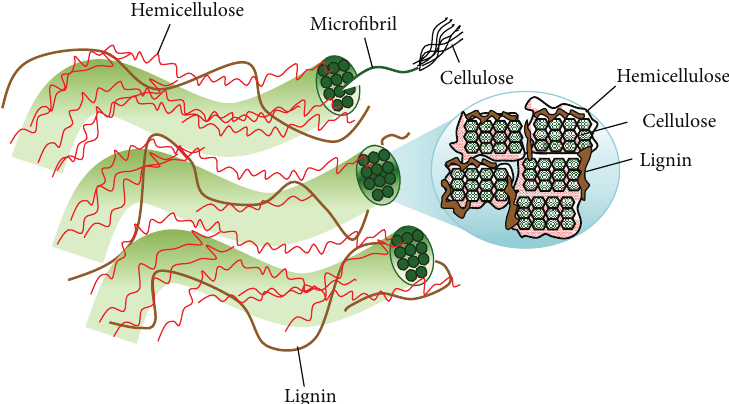
Figure 2: Plant cell wall structure and microfibril cross-section (strands of cellulose molecules embedded in a matrix of hemicellulose and lignin).